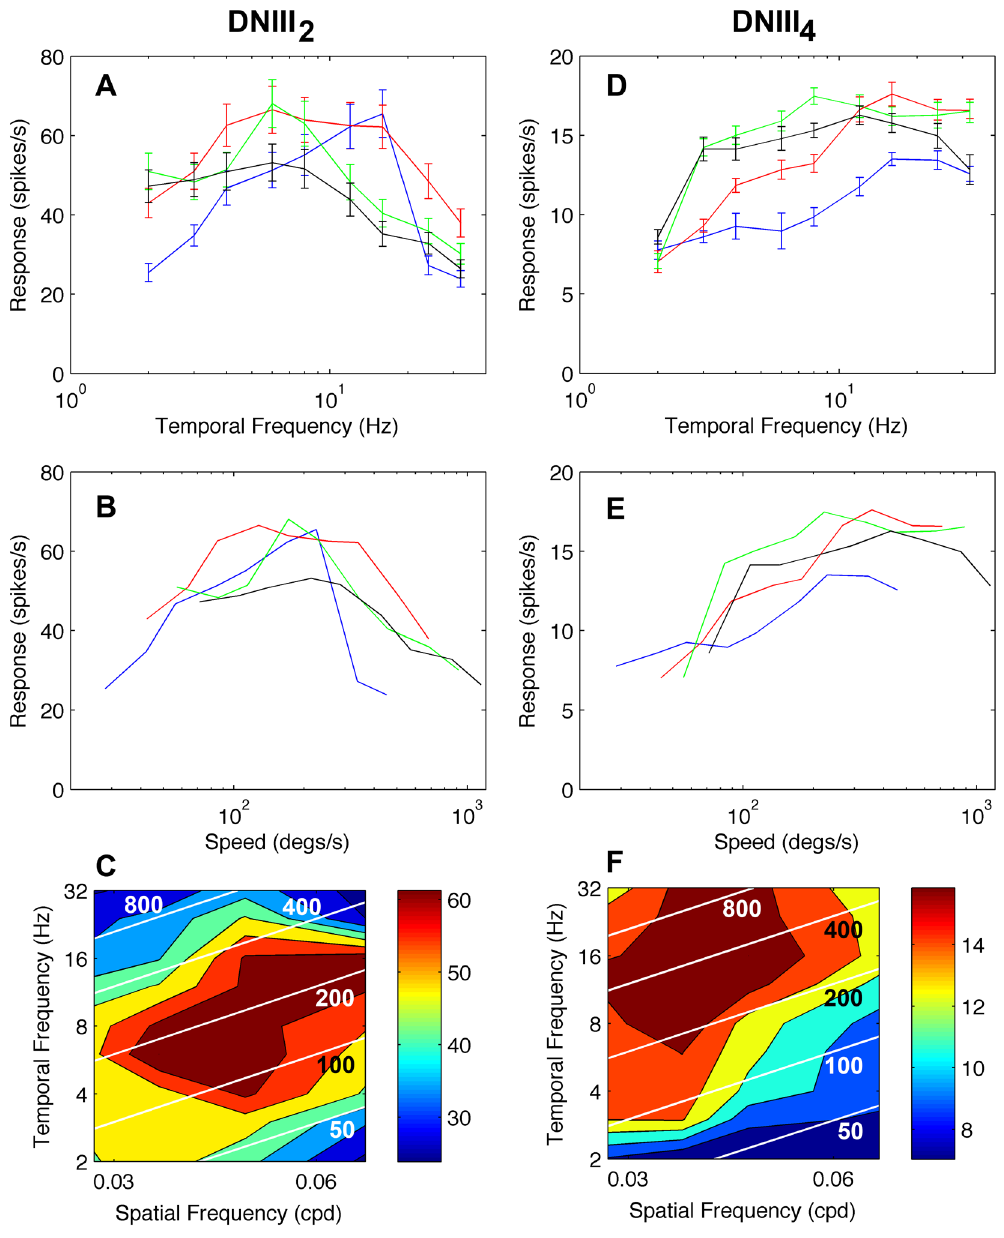
Figure 6. Speed tuning of two identified DNIII neurons. ( A ) Mean temporal frequency tuning for 3 DNIII 2 neurons at four different spatial frequencies (black: 0.028 cycles/° (cpd), green: 0.035 cpd, red: 0.047cpd, blue: 0.071cpd). In this plot the mean values are the means across 3 high quality recordings. ( B ) The same data as in A but plotted with image speed on the x-axis. ( C ) Color-coded spatiotemporal contour map of the spike rate. The colors represent the spike rate as shown by the legend. The white lines represent constant image speeds (50, 100, 200, 400 and 800°/s). ( D , F ) The same format of figures for cell DNIII 4 . In this case the response presented was from one high quality recording during which all spatial and temporal frequencies were repeated at least 3 times. Error bars in A and D are standard